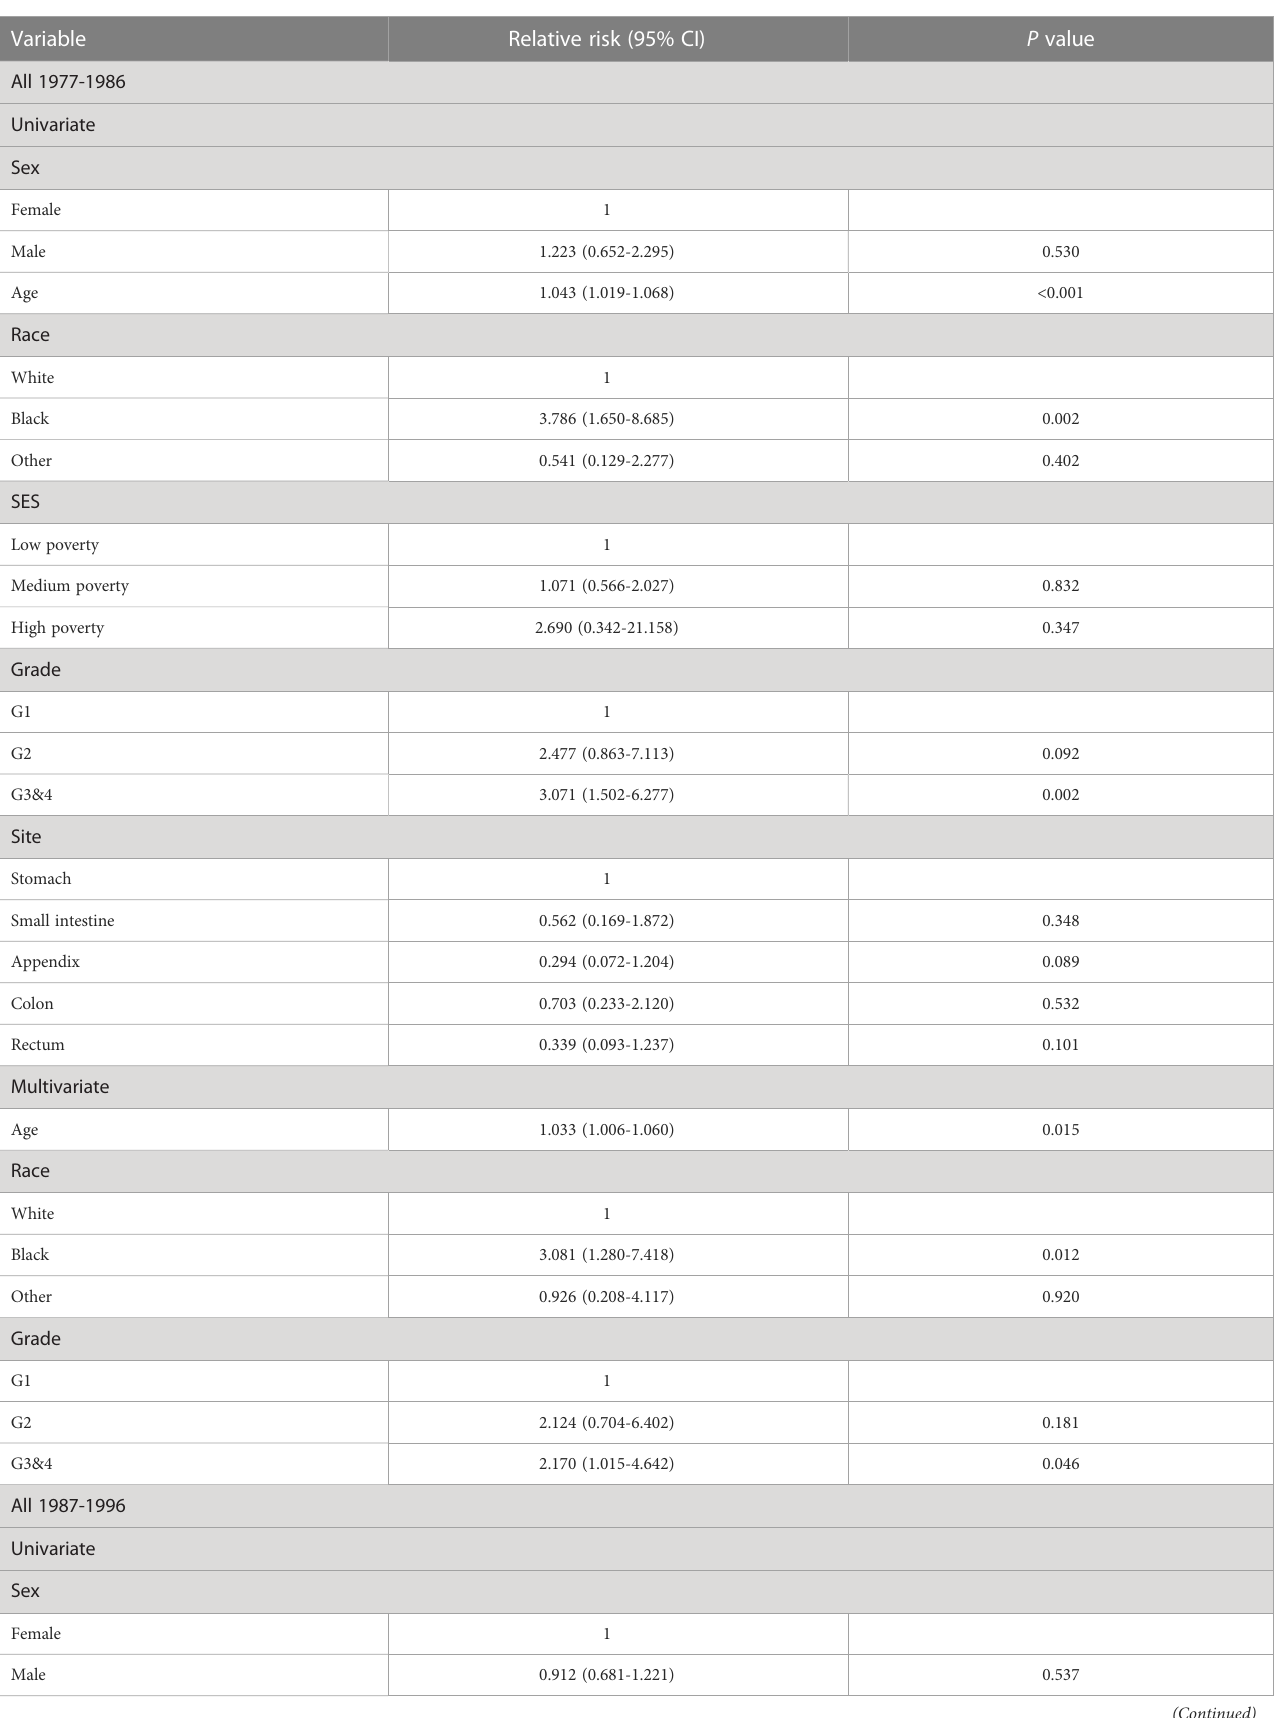
TABLE 2 Summary data for Cox regression analysis of survival in patients with GI-NETs from 1977 to 2016 at nine SEER sites.